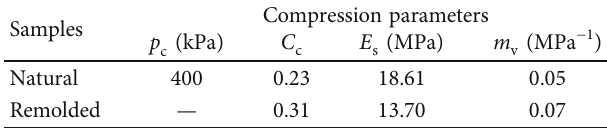
′ curves and (b) I ′ curves. – log σ v v v Table 3: Compressibility of natural and remolded